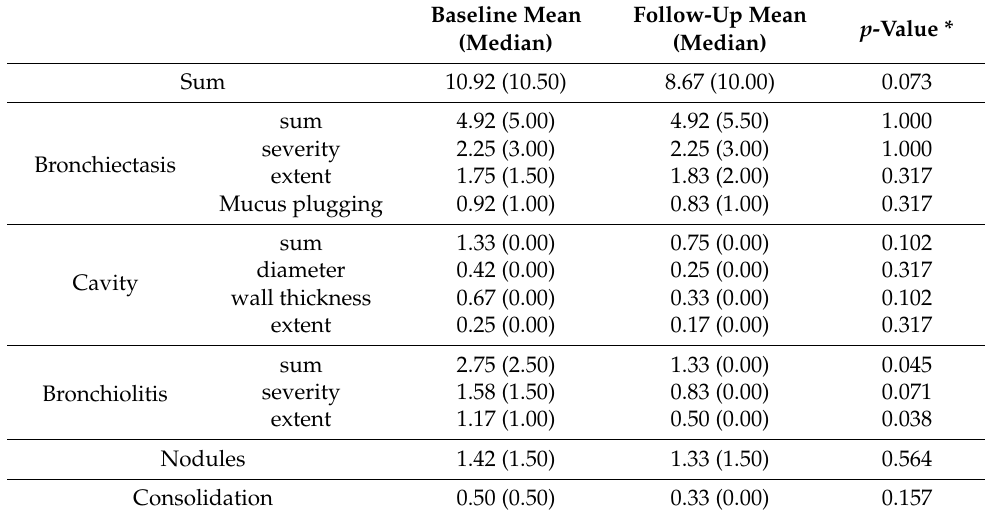
Table 5. Follow-up data in CT after microbiological cure.